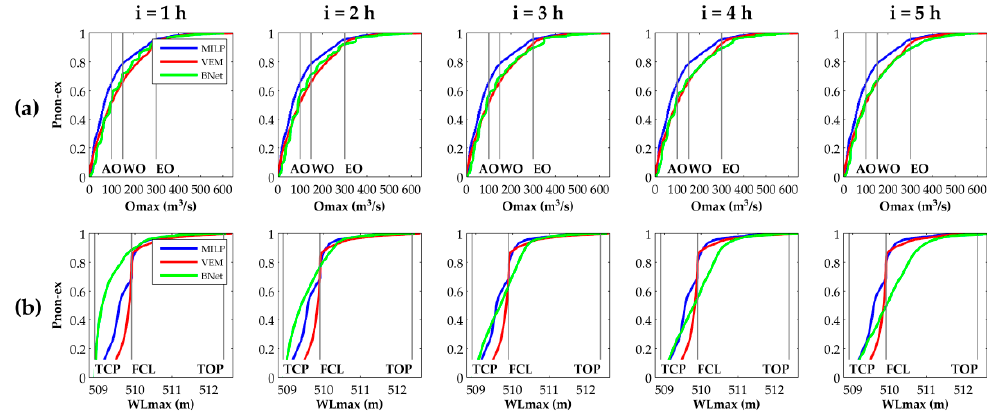
Figure 11. Probabilities of non-exceedance of: ( a ) maximum discharge flows ( O max ) and ( b ) maximum levels ( WL max ), obtained with the VEM, MILP, and BNet i ( i = 1, ... , 5